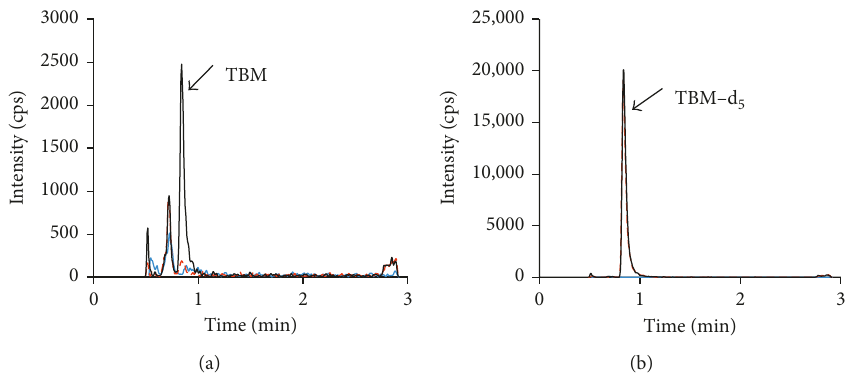
Figure 2: Chromatograms of blank M 9 medium (blue solid line), blank M 9 medium spiked with IS (red dash line), and TBM at LLOQ level (black solid line). (a) TBM channel; (b) the IS channel.